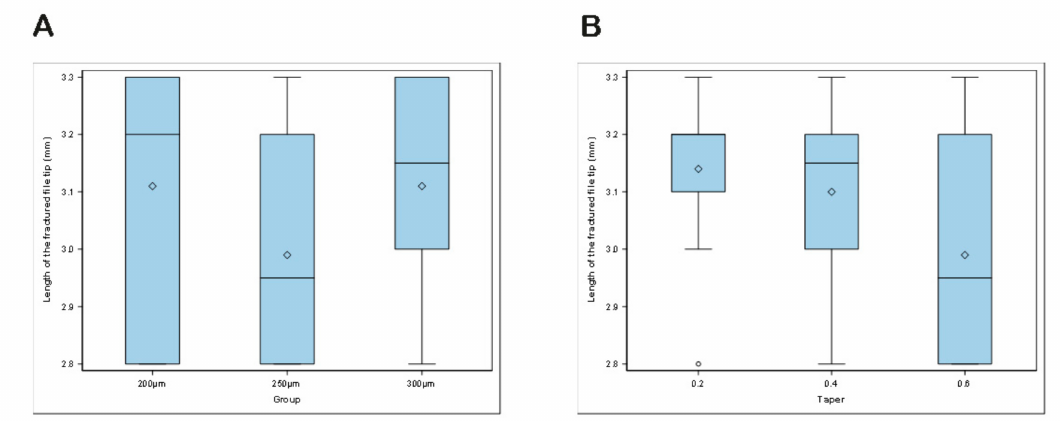
Figure 11. Box plots of the length of fractured files regarding the ( A ) apical diameter and ( B ) taper study groups. The horizontal line in each box represents the respective median value.